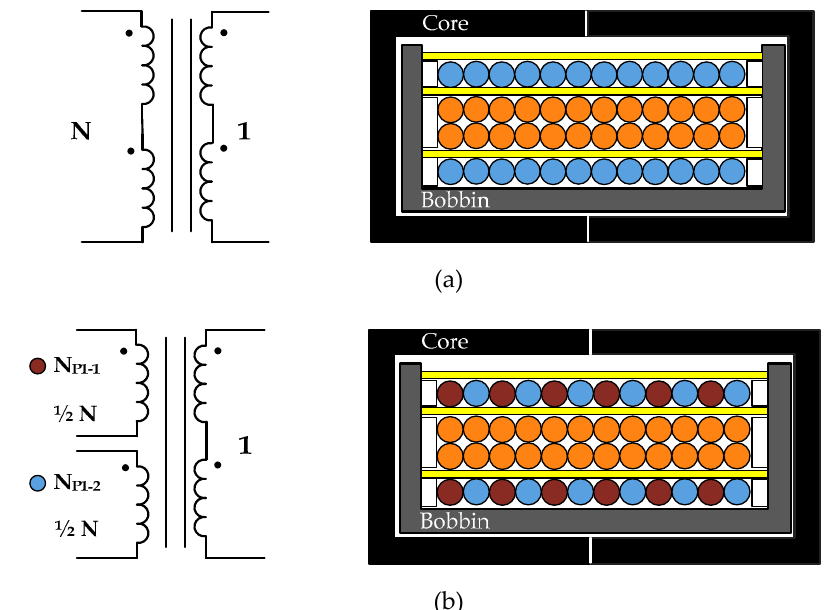
Figure 9. Transformers winding method. ( a ) Winding of independent transformers, ( b ) winding of multiple input transformers.